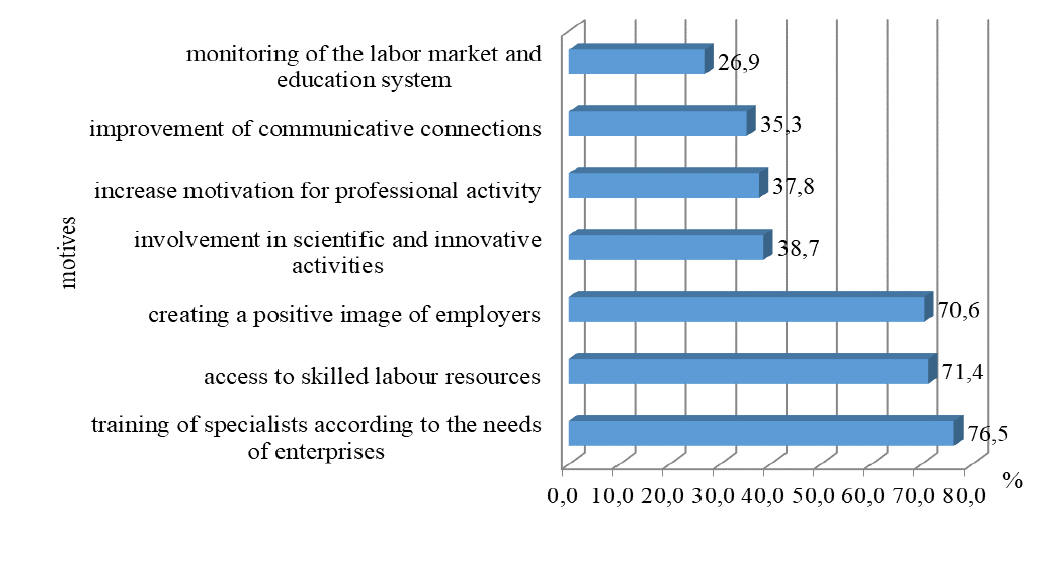
Fig. 1. Motives of cooperation of employers with the institution of higher